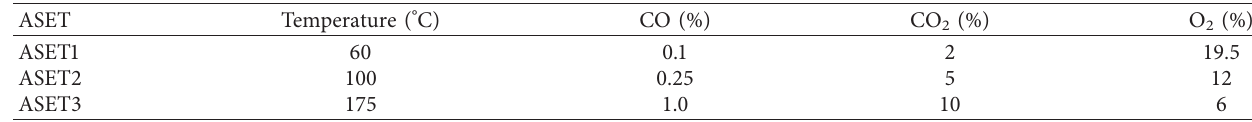
Table 11: ASET’s quantitative indicators of fire products.